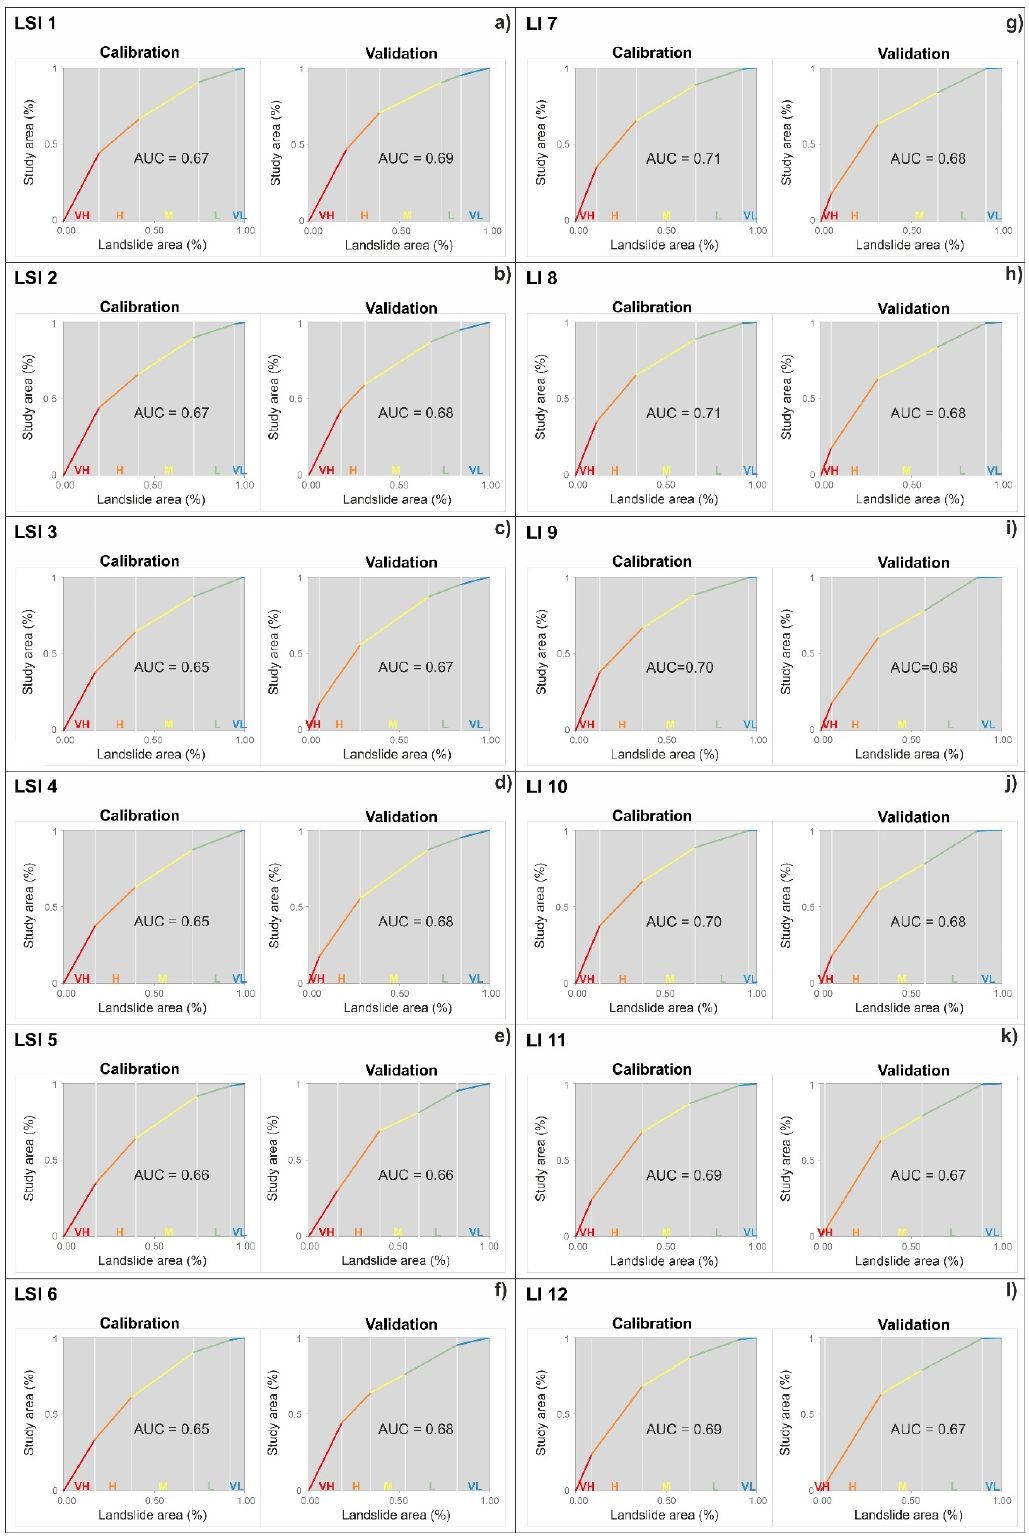
Figure 11. ROC curves with AUC values for the calibration and validation procedures (x-axis, percentage of the cumulative landslides area in each susceptibility classes; y-axis, percentage of the cumulative study area in each susceptibility classes) of the different models: ( a ) LSI_1 model; ( b ) LSI_2 model; ( c ) LSI_3 model; ( d ) LSI_4 model; ( e ) LSI_5 model; ( f ) LSI_6 model ( g ) LI_7 model; ( h ) LI_8 model; ( i ) LI_9 model; ( j ) LI_10 model; ( k ) LI_11 model; ( l ) LI_12 model.